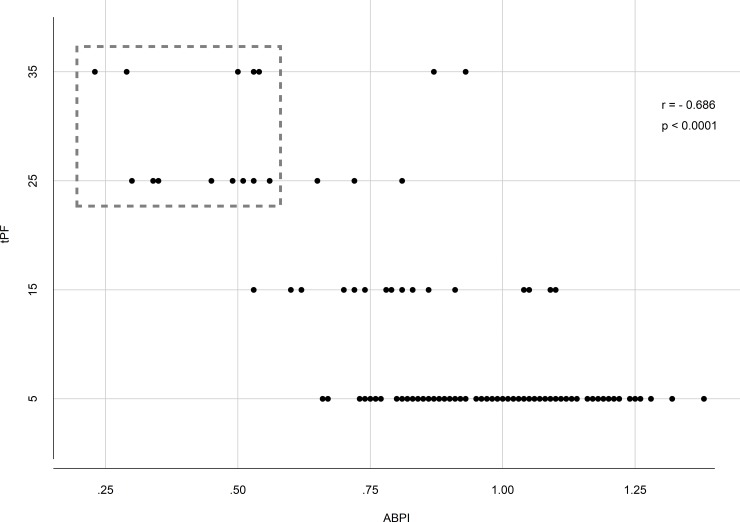
Scatter plot for the correlation between tPF (vertical axis) and ABPI (horizontal axis).There is a significant correlation between tPF in PAD patients with ABPI values less than 0.7 (dash-lined box in the plot).